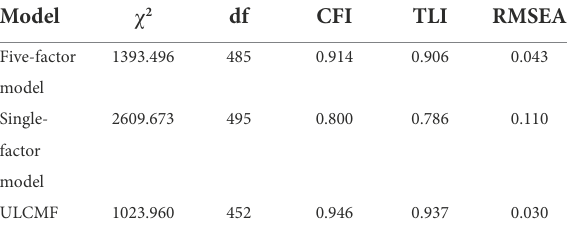
TABLE 1 Common method bias